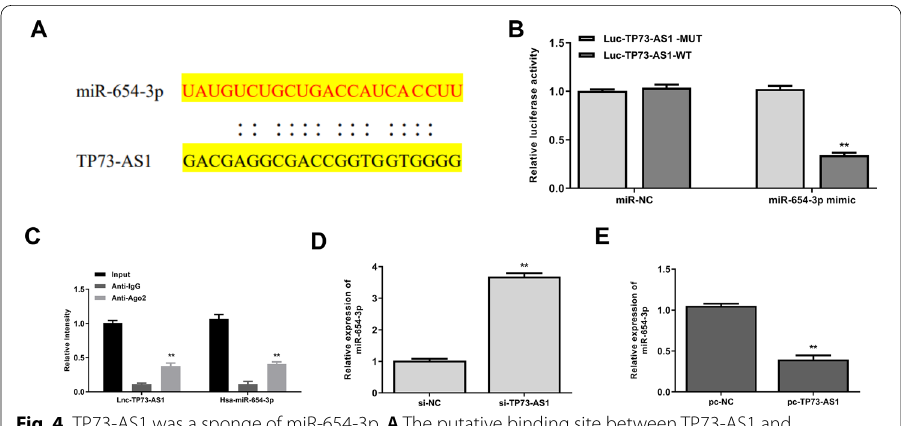
Fig. 4 TP73-AS1 was a sponge of miR-654-3p. A The putative binding site between TP73-AS1 and miR-654-3p predicted by StarBase. B Results of dual luciferase reporter assay. C Enrichment of TP73-AS1 and miR-654-3p in miRNPs determined by RIP assay using anti-Ago2 antibody. D MiR-654-3p expression detected by qRT-PCR in HAECs transfected with si-TP73-AS1 or si-NC. E MiR-654-3p level detected by qRT-PCR in HAECs transfected with pc-TP73-AS1. **P <